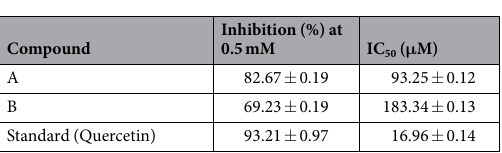
Table 1. Results of DPPH radical scavenging activities of compounds A &